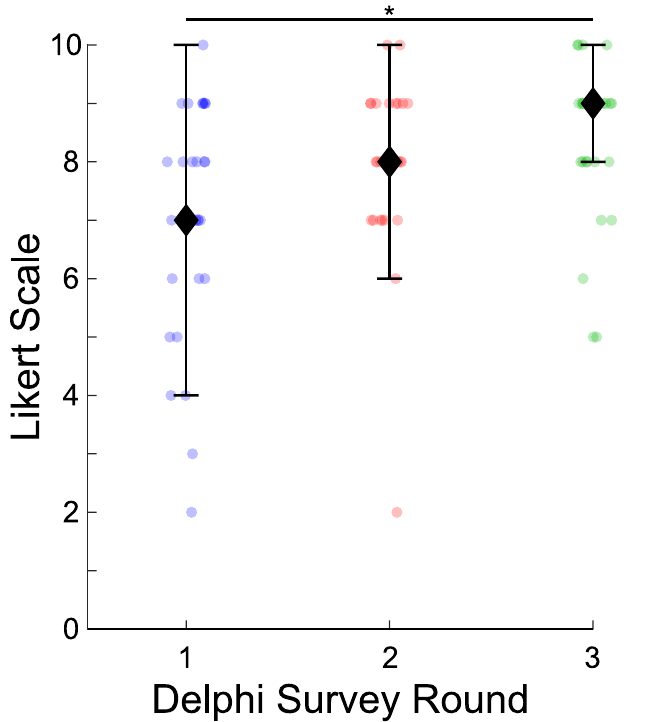
Fig 3. Subjective rating of the running level definitions for the three rounds of this Delphi study. Changes in subjective ratings were accompanied by updating the running levels definition based on respondents’ feedback. The diamonds represent the median of each round and the bars indicate the interquartile range. Each shaded dot indicates one response made by a respondent. The asterisk ( � ) indicates a statistical difference in the subjective ratings ( p = 0.006).